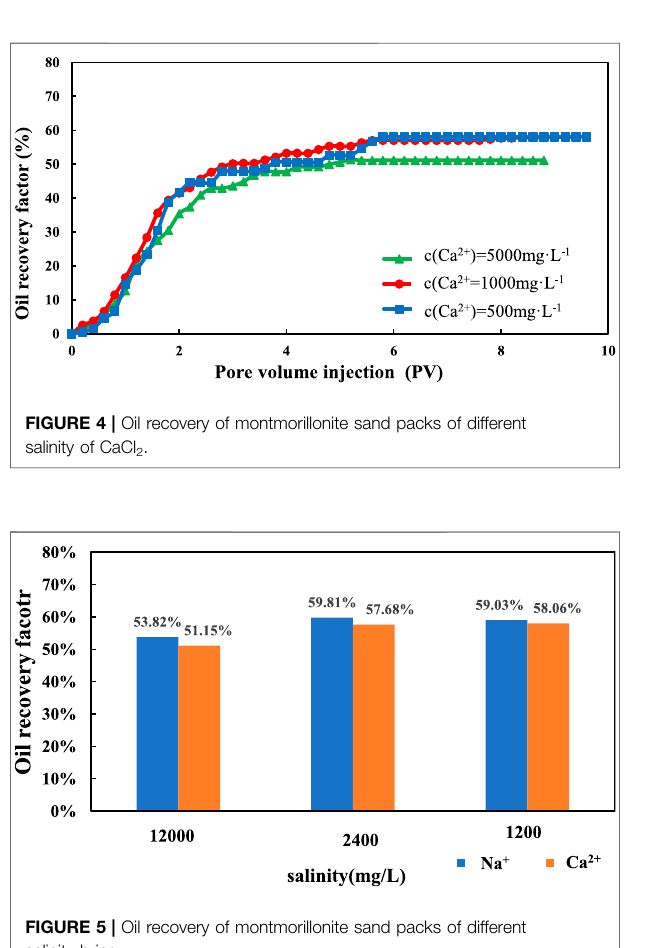
FIGURE 6 | Oil recovery of kaolinite sand packs of different salinity of NaCl.